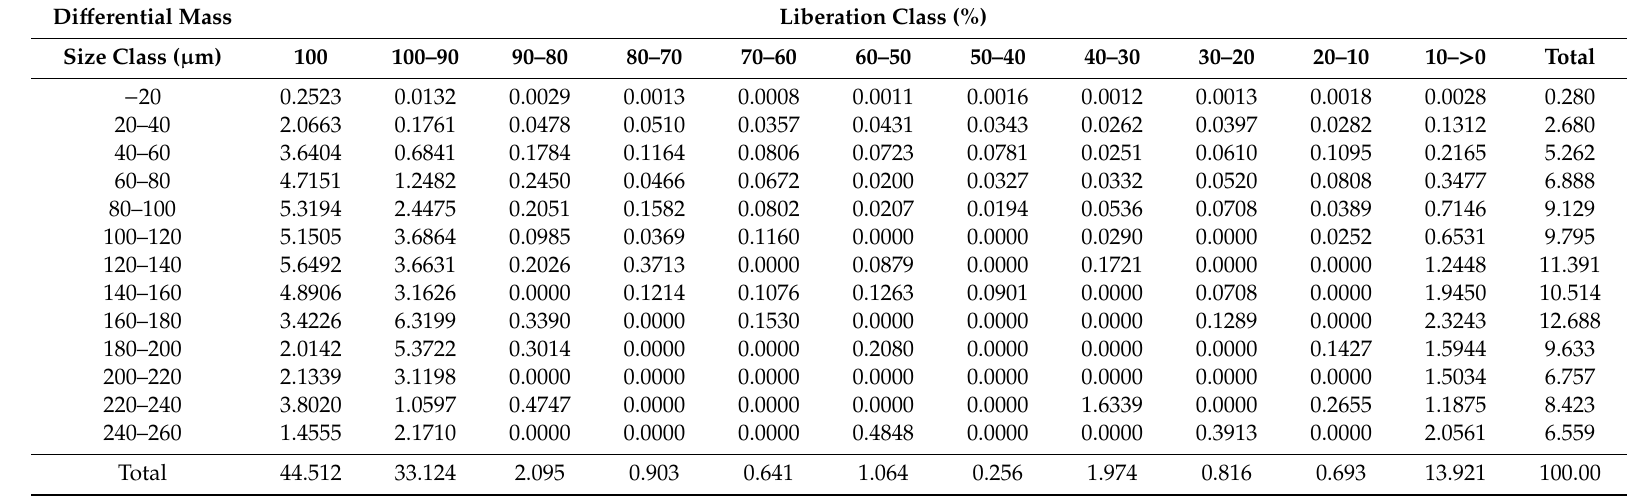
Table 4. Scheelite distribution by particle size and liberation (di ff erential